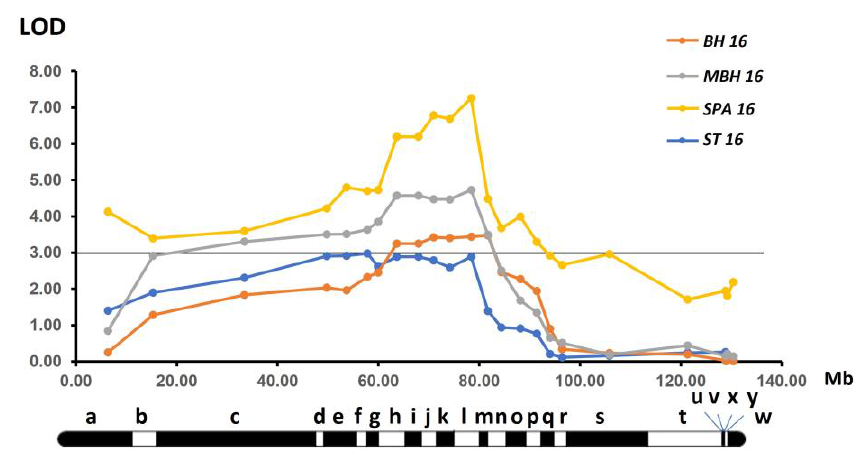
Figure 6. ( A ) QTLs detected for several morpho-agronomic traits on chromosome 5 of A. officinalis . The traits are mean branching height (BH), maximum branching height (MBH), and earliness measured as spear area (SPA) and stalk thickness (ST). The LOD is calculated as − Log 10 ( P ) values. The horizontal black line is the established threshold of LOD ≥ 3. ( B ) Bin map of chromosome 5.